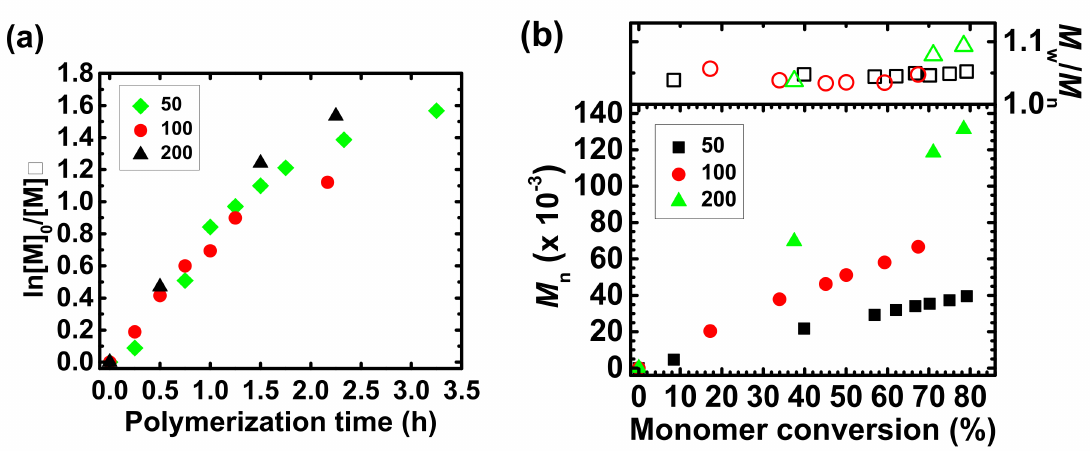
Figure 2. ( a ) First-order kinetics plot of monomer conversion vs. polymerization time of t BA from the troxerutin core with different target degrees of polymerization; ( b ) M n and M w / M n vs. monomer conversion. Table 1, entry